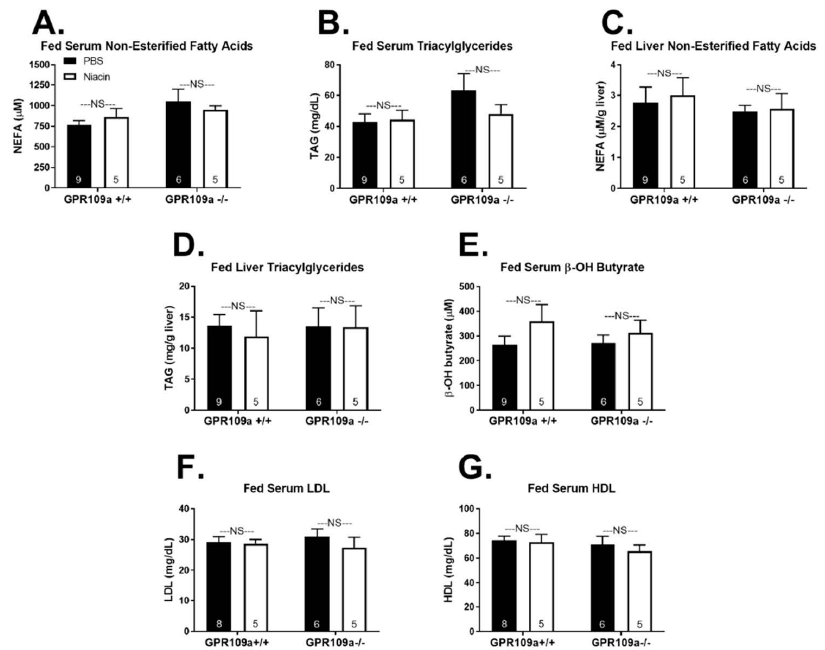
Figure 2. Effect of niacin on lipid and cholesterol homeostasis in fed GPR109a +/+ and − / − mice. Serum ( A ) non-esterified fatty acids (NEFA; µ M) and ( B ) triacylglycerol (TAG; mg/dL). Hepatic ( C ) non-esterified fatty acids (NEFA; µ mol/g liver tissue) and ( D ) triacylglycerol (TAG; mg/g liver tissue). Serum ( E ) β -OH butyrate ( µ M), ( F ) low-density lipoprotein (LDL; mg/dL), and ( G ) high-density lipoprotein (HDL; mg/dL). Direct comparisons were made between injection treatments within genotype. NS = non-significant; p > 0.05; PBS = phosphate-buffered saline. Numbers inside bars denote the n per